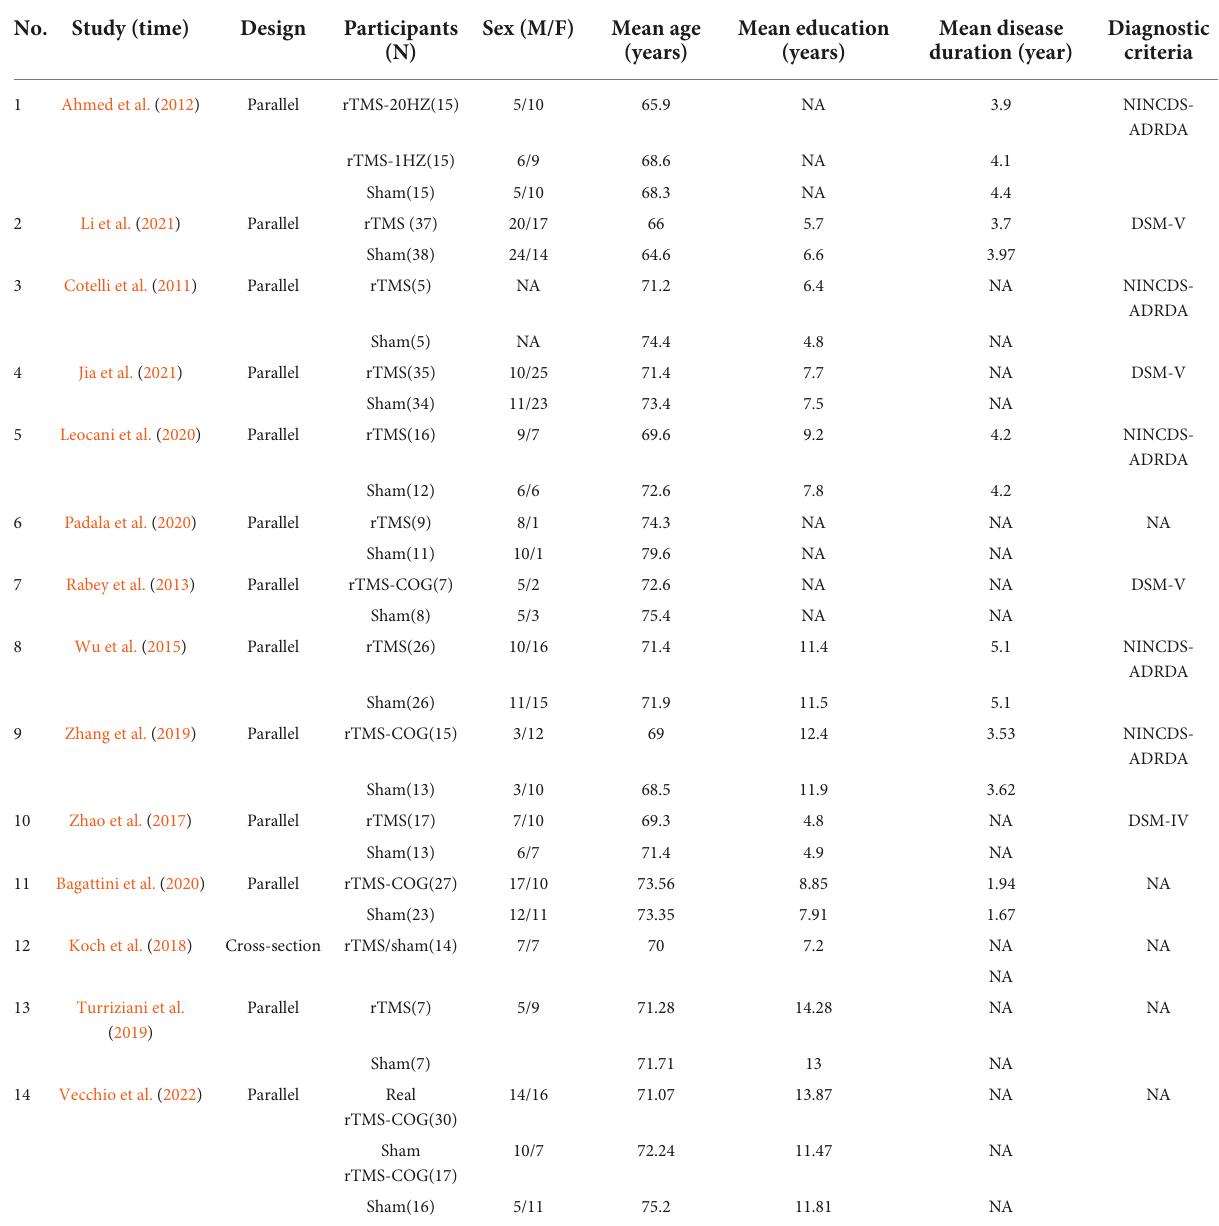
TABLE 1 Demographic characteristics of included